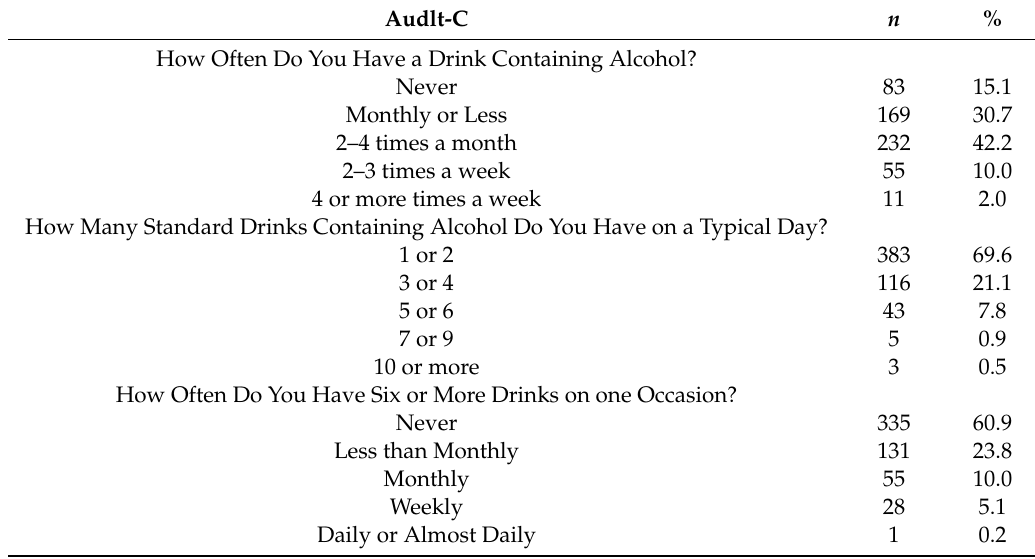
Table A1. AUDIT-C ( n =